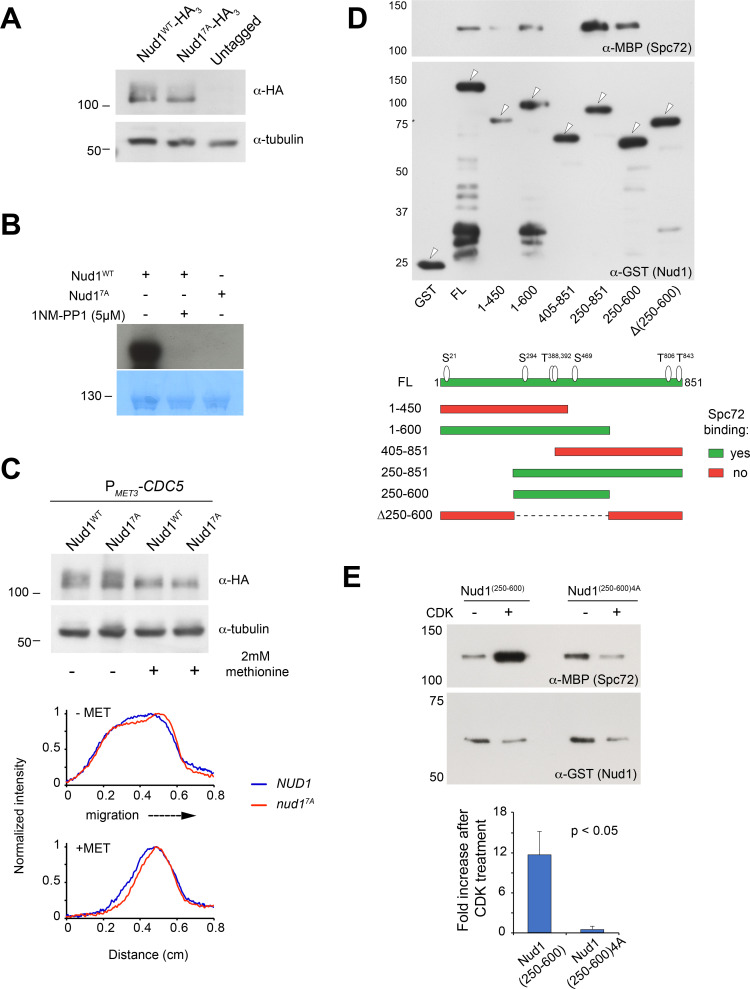
Nud1 and Nud17A characterization in vivo and in vitro.(A) Nud1WT-HA3 and Nud17A-HA3 levels assessed by western blot analysis of cell extracts prepared from asynchronous cultures of the parent strains analyzed in Figure 5. (B) Kinase assay using 4 µg of purified MBP-Nud1WT or MBP-Nud17A and 19 ng of purified Twin-Strep-Clb5∆db/Cdc28-as/Cks1 was carried out as described under Materials and methods. 5 µM 1NM-PP1 was added to inhibit Cdc28-as (analog-sensitive CDK). Reactions were resolved by SDS-PAGE and blotted onto a PVDF membrane (bottom) that was exposed to film overnight (top) (C) CDK sites in Nud1 contribute to bulk phosphorylation in vivo. Western blot analysis of whole cell extracts from cells expressing Nud1WT-HA3 or Nud17A-HA3 before or after depletion of Cdc5 under the control of the repressible MET3 promoter was carried out as described under Materials and methods. Cdc5 also contributes to Nud1 mobility shift by phosphorylation. A further decrease in mobility shift was observed in cells expressing Nud17A versus wild type Nud1 following Cdc5 depletion. Linescans along the direction of electrophoretic migration show the relative down-shift of Nud17A-HA3 (in red). (D) A Nud1 domain between amino acid positions 250–600 was necessary and sufficient for Spc72 binding in vitro. Previous yeast two-hybrid studies suggested that the Nud1 C-terminus (residues 405–852) associated with Spc72 (Gruneberg, 2000). (E) Spc72 pull down by Nud1(250-600) showing enhanced binding following CDK phosphorylation as described for full-length Nud1 in Figure 5J.